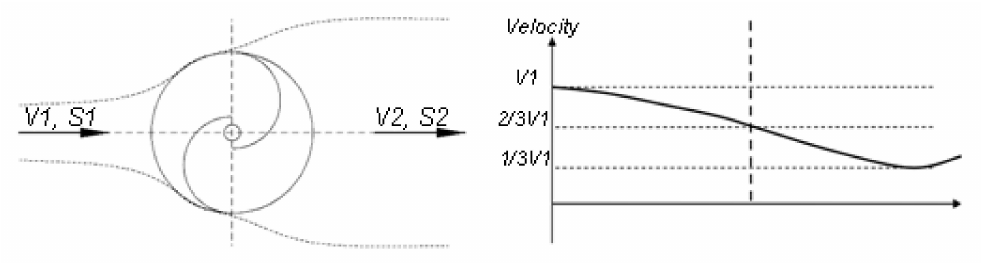
Figure 1. The ideal wind turbine model and air velocity modification [60].